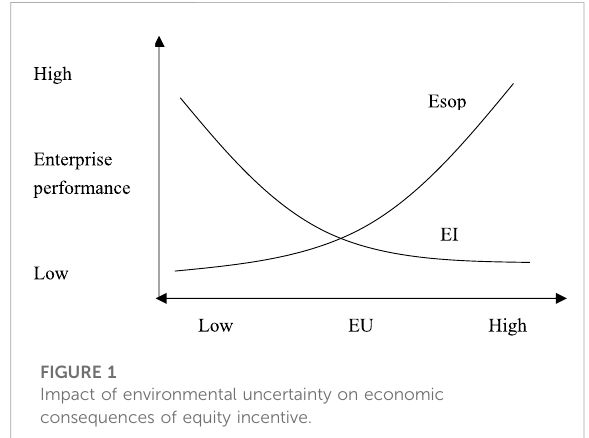
FIGURE 1 Impact of environmental uncertainty on economic consequences of equity